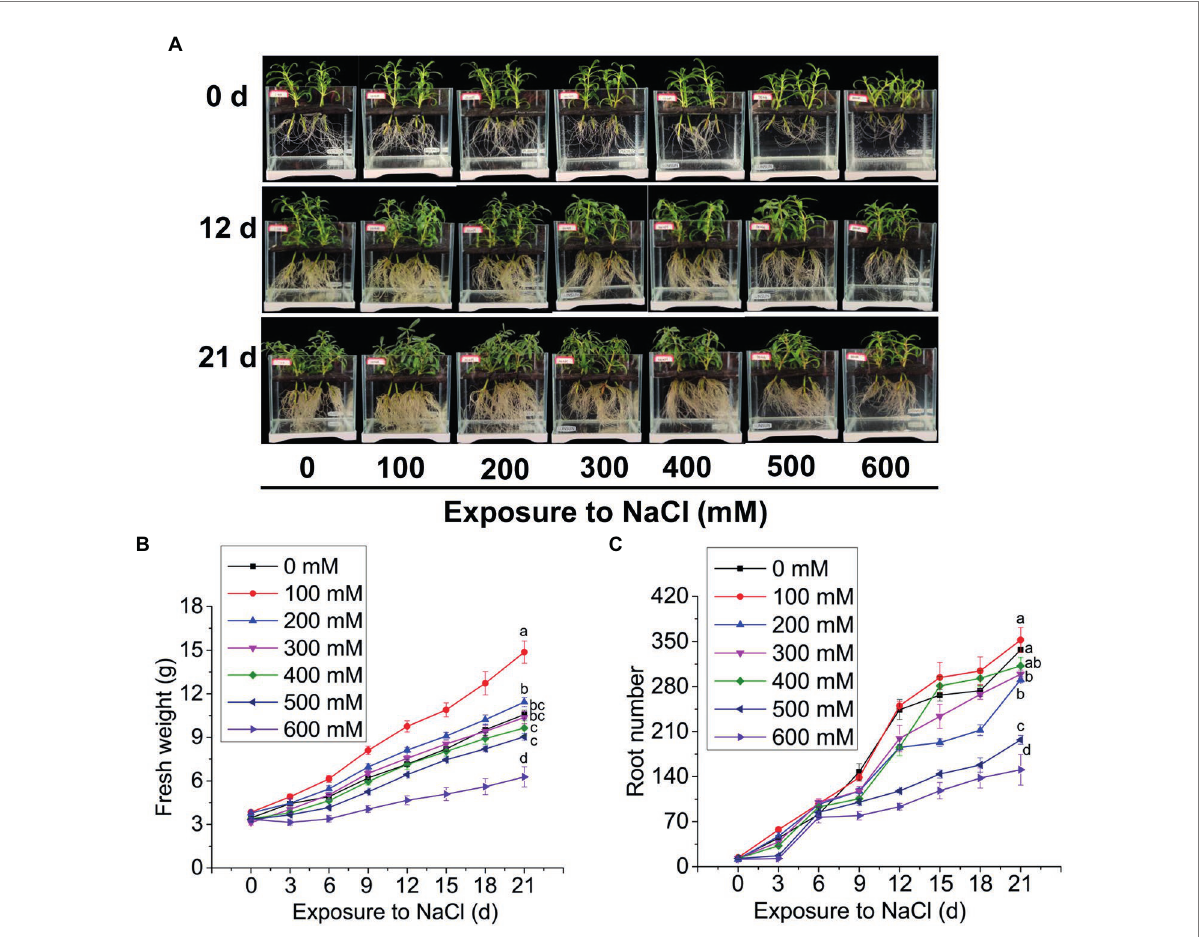
FIGURE 1 The growth of Sesuvium portulacastrum in a hydroponic culture. The phenotype of S. portulacastrum plants grown in different concentrations of NaCl over 0, 12, and 21 days (A) , fresh weight (B) , and root numbers (C) of plants over 21 days of growth. Data were means of three replications. Different letters at the end of lines indicate significant differences among treatments based on Tukey HSD test at p < 0.05